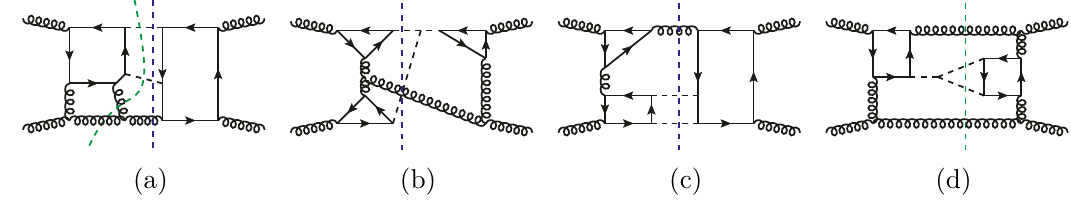
Figure 2 . Sample Feynman diagrams in the forward-scattering kinematics. Three- and four-particle cuts are shown by blue and green dashed lines, respectively. The n 3 have already been considered in [31] but those in (c) have not; they are considered